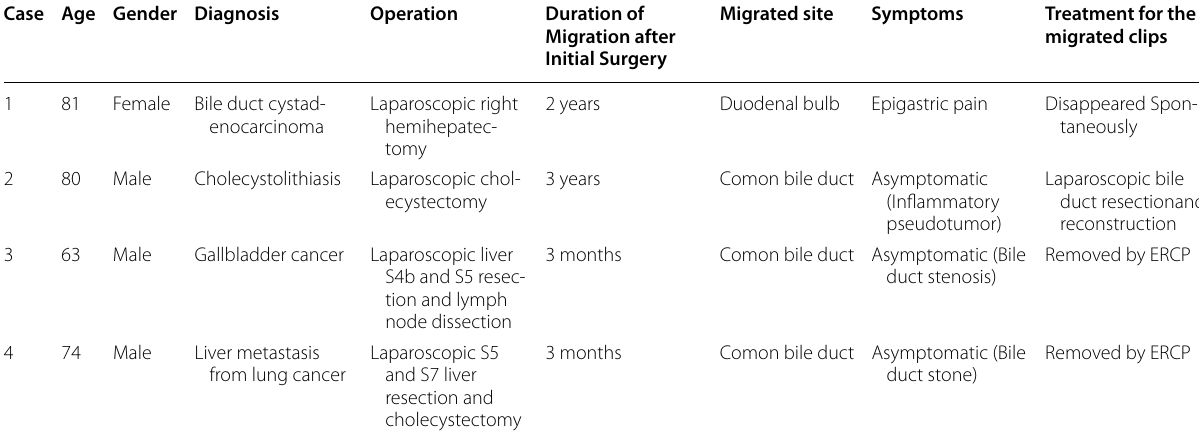
Table 1 Patient Characteristics and Results Case Age Gender Diagnosis